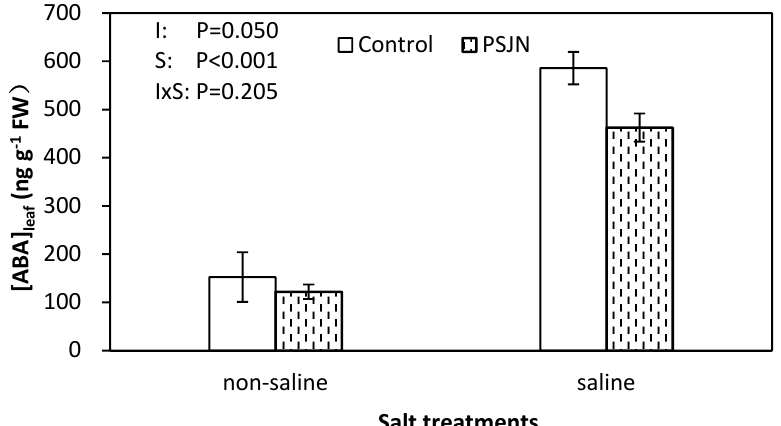
Figure 4. Leaf abscisic acid (ABA) concentrations of quinoa leaves affected by bacterial inoculation in non-saline (0 mM NaCl) and saline (400 mM NaCl) irrigations. PsJN indicates Burkholderia phytofirmans PsJN . I and S indicate inoculation and salinity treatments, respectively, and I × S indicates the interaction. Error bars indicate S.E. ( n = 4).